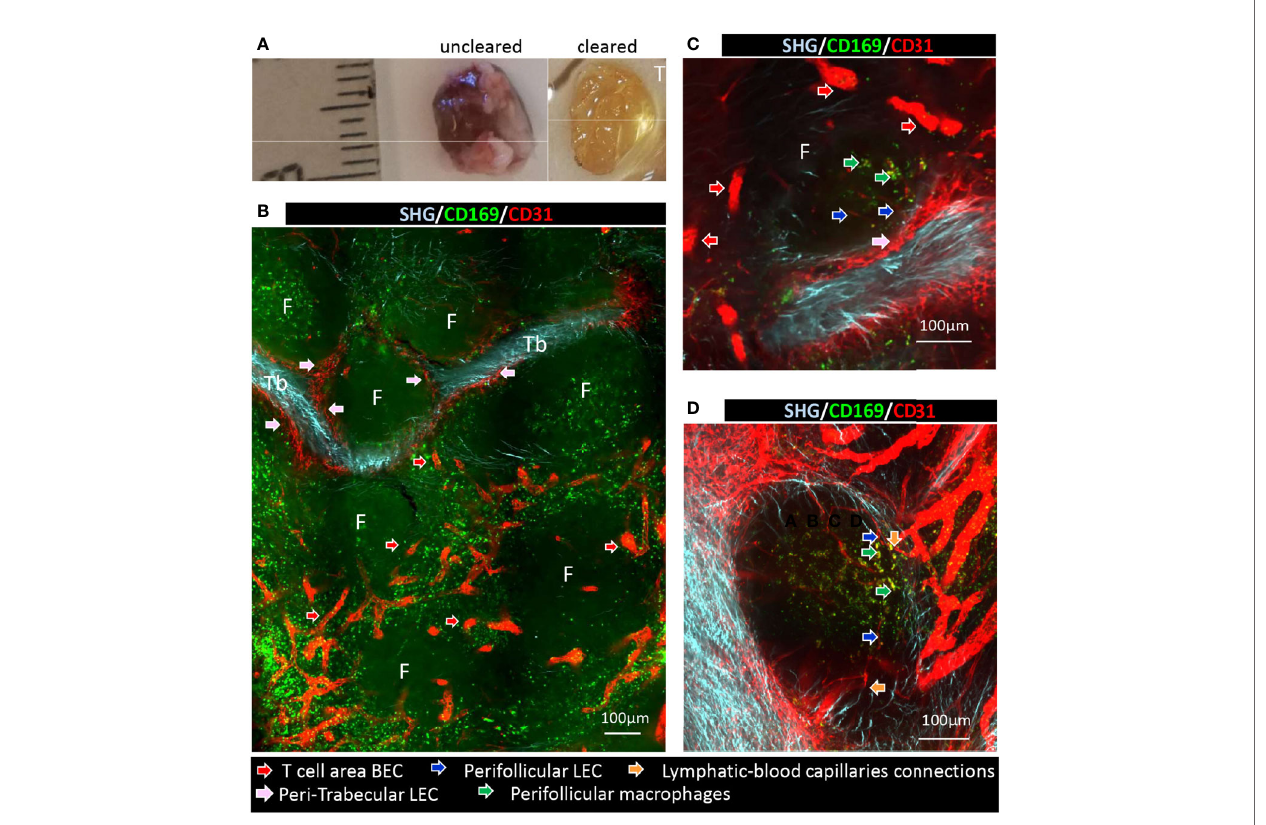
FIGURE 4 | Trabecular sinus, perifollicular sinus and blood vessels interconnections in relation with the perifollicular macrophages. (A) Thick slice of tracheobronchial LN were cleared using iDISCO+ and (B – D) different area and magni fi cations of cleared LN slice stained with anti-CD169 and anti-CD31 antibodies. Imaged with multiphoton microscope A1RMP+ with an objective lens 25x and dual excitation at 960 nm and 1040nm. From 960 nm excitation, Second Harmonic generation (SHG) was acquired in blue channel in forward direction and fl uorescence of Alexa Fluor 488 was acquired in green channel in backward direction. From 1040 nm excitation, fl uorescence of Alexa Fluor 555 was acquired in red channel in backward direction. F, follicle; Tb, Trabeculae. Red arrows: T cell area blood endothelial cells, pink arrows: peri-trabecular lymphatic endothelial cells, dark blue arrows: perifollicular lymphatic endothelial cells, green arrows: perifollicular macrophages, orange arrows: lymphatic-blood capillaries connections. (A – C) , scale bar